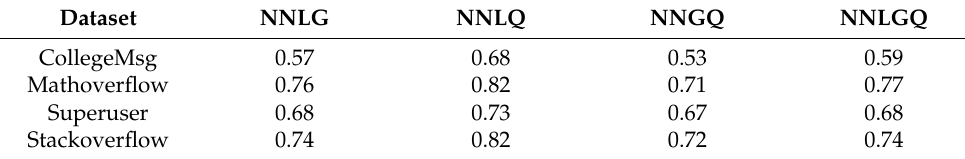
Table 2. The AUC value of four feature fusion algorithms on different datasets.